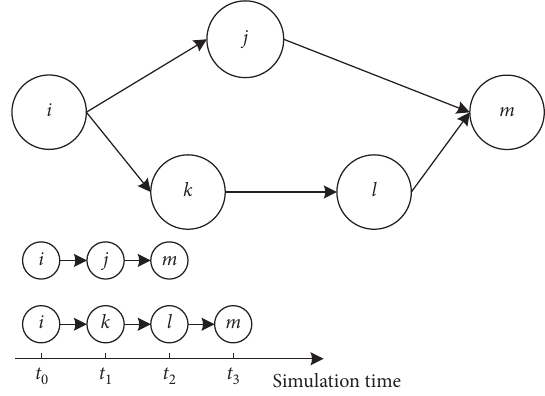
Figure 2: Project time and simulation time.